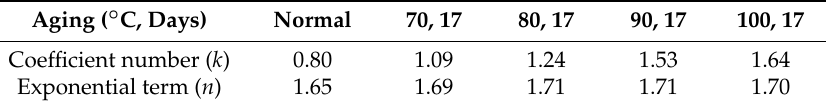
Figure 1. ( a ) Crosslink density expressed as a parallel spring model; ( b ) SED function expressed as a parallel spring model. Table 4. Change of SED function coefficient with aging.